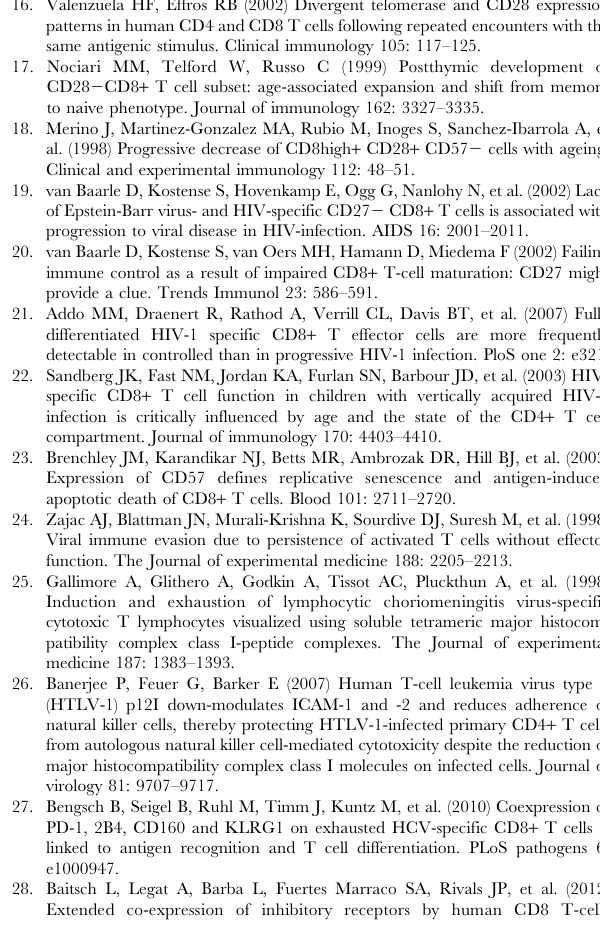
Figure S1 A positive correlation between PD-1 + CD4 + T cells and HIV plasma viral load (VL) in children. Scatter plots showing correlation between HIV-1 plasma viral load (VL) and Tim-3 + CD4 + T cells, and PD-1 + CD4 + T cells in children (A and C) and adolescents (B and D) respectively. PD-1 + CD4 + T cells show a significant direct correlation with HIV-1 plasma viral load (VL) in children with shorter duration of HIV infection (Spearman r= 0.88, *p= 0.033).